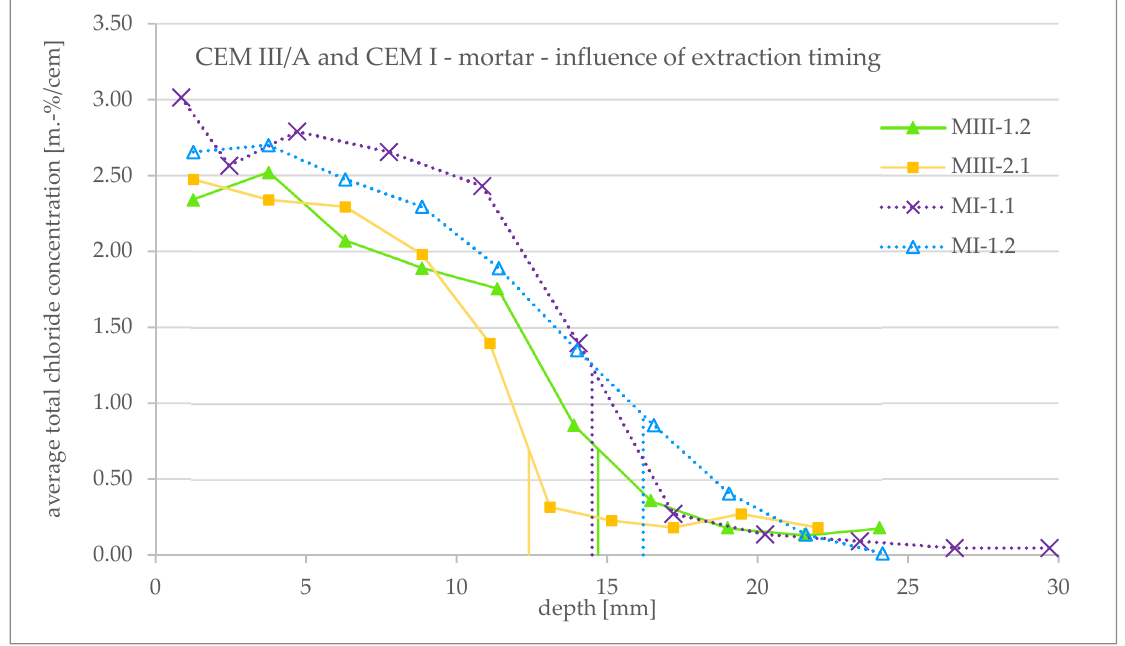
Figure 9. Influence of timing of concrete powder extraction on total chloride concentration profiles obtained after an RCM test for CEM III/A and CEM I mortar specimens. For specimen MIII-2.1 and MI-1.1, powder extraction was performed directly after the end of the RCM test; for MIII-1.2, extraction was performed about 3.5 weeks after the end of the test; and for MI-1.2, extraction was performed about 4.5 weeks after the end of the test.